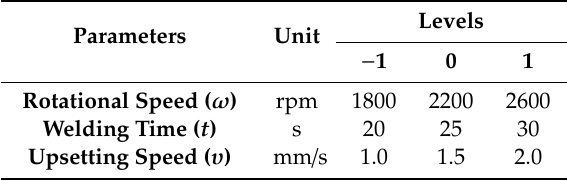
Table 3. Coded and actual values of FPW